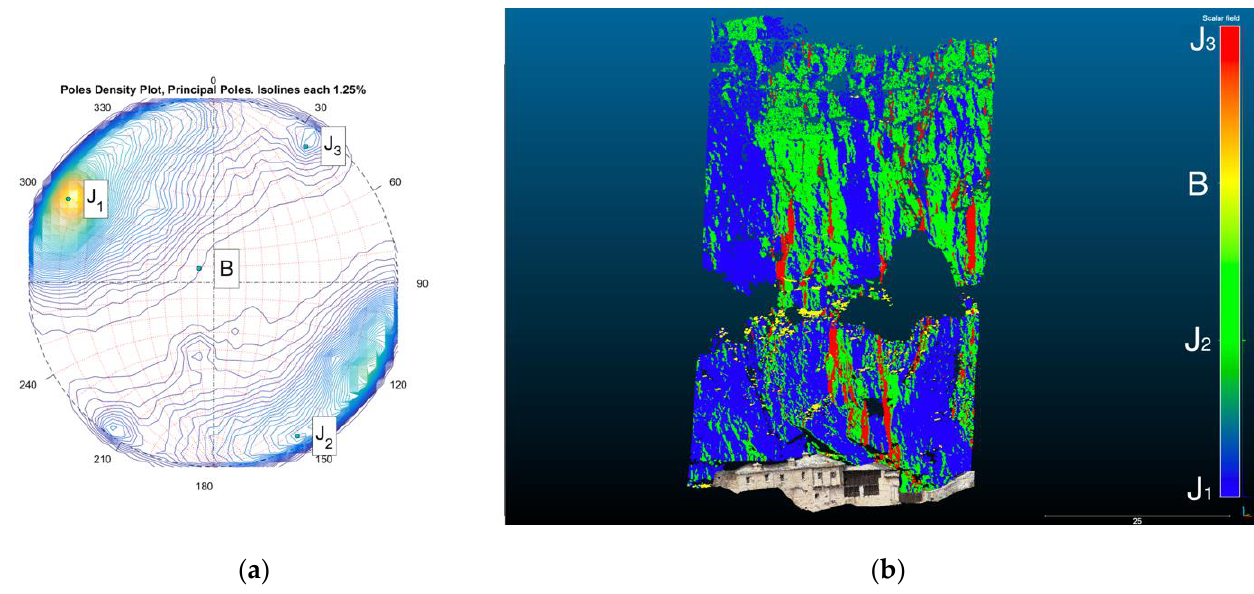
Figure 6. ( a ) Stereographic projections of the DSE-derived discontinuity sets for U1 and ( b ) the visual interpretation of the four (4) main sets in the 3D point cloud.